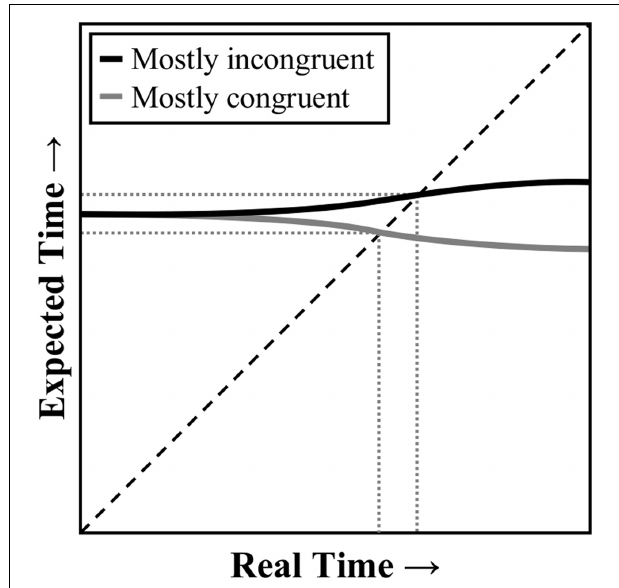
FIGURE 3 | Illustration of a temporal learning mechanism as it relates to context-specific proportion congruent effects. At the start of the trial, the expected time to respond is the same for a mostly congruent or mostly incongruent stimulus. However, as the contextual stimulus (e.g., location) is processed, the expected time to respond can adjust dynamically. The response threshold is decreased when real time is close to the expected time to respond. Dashed line represents where expected time equals real time. Dotted lines indicate the points where the current expectancy (solid line) intersects with current real